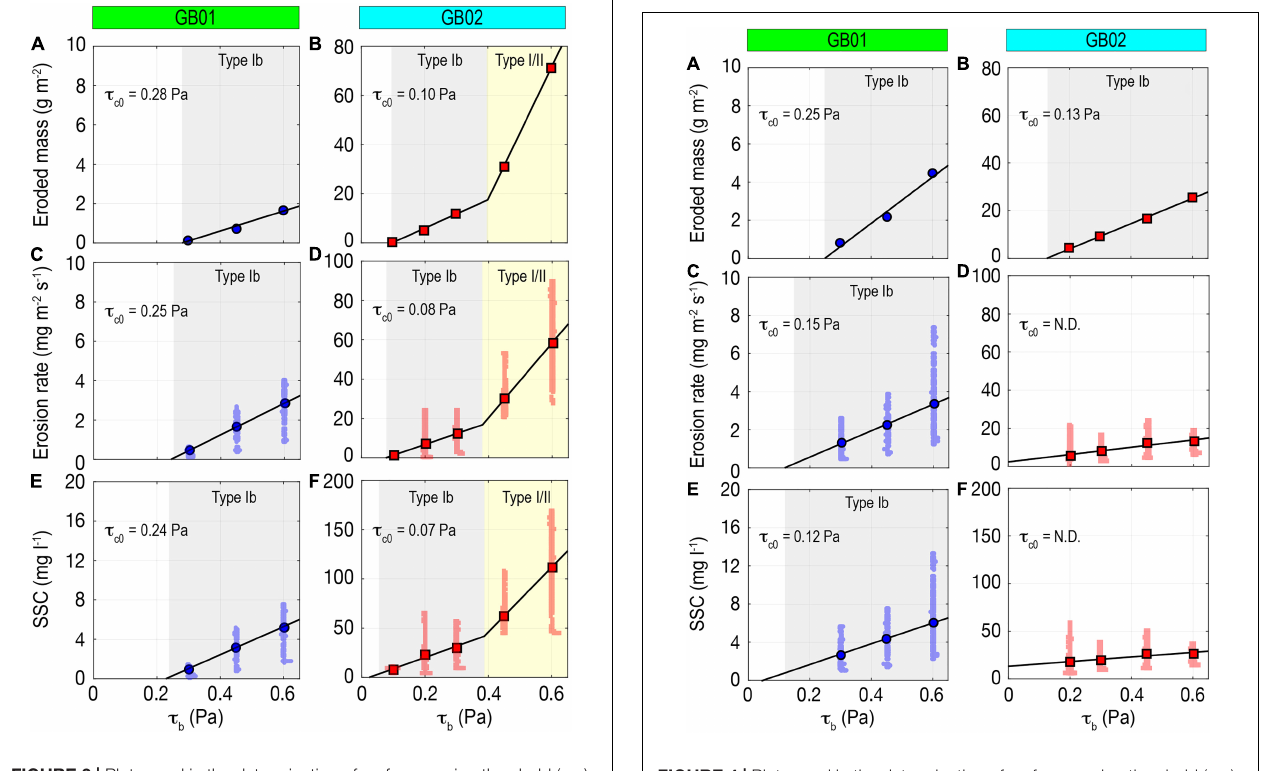
squares indicate mean values at each step of τ b . Black solid lines indicate the fitting of regression line. Areas of light gray and yellow indicate the erosion of type Ib and type I/II, respectively.